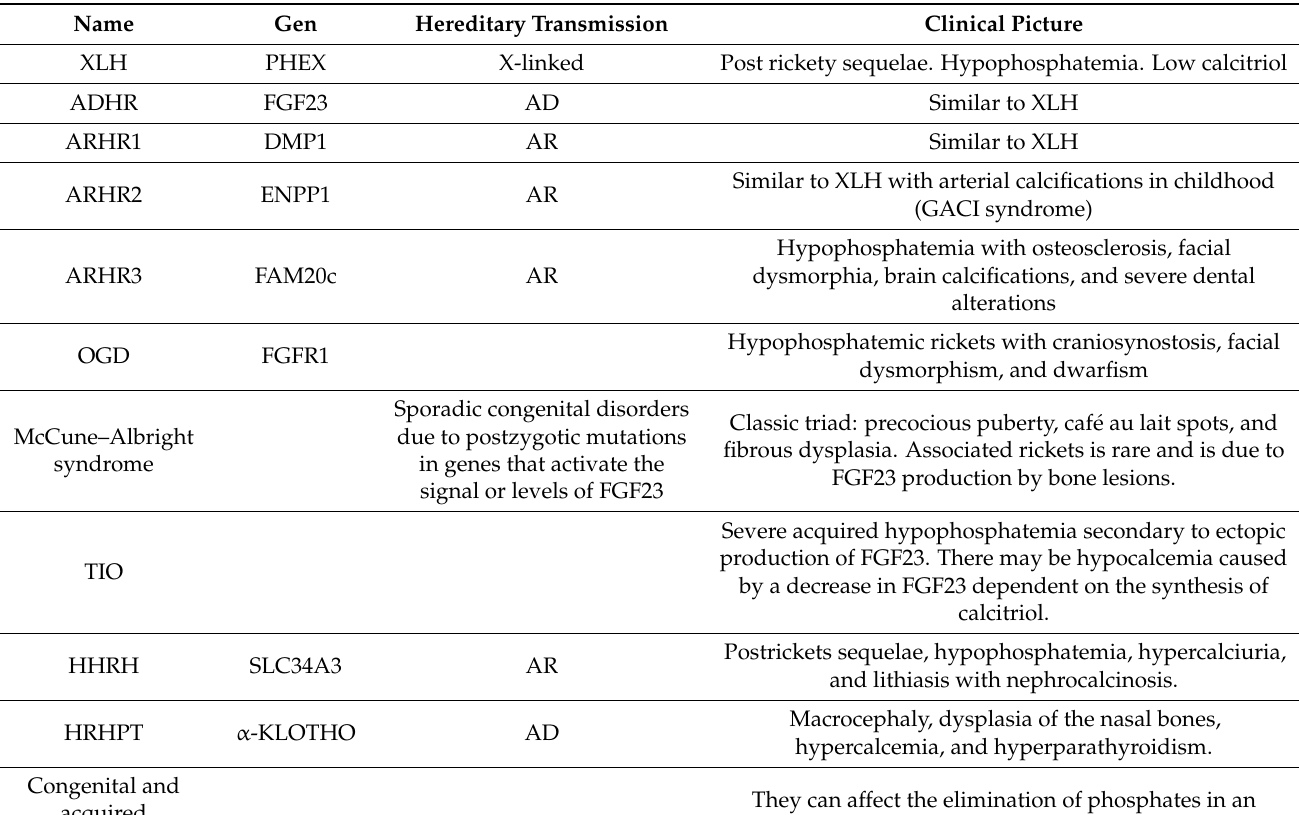
Table 2. Characteristics of renal phosphate wasting